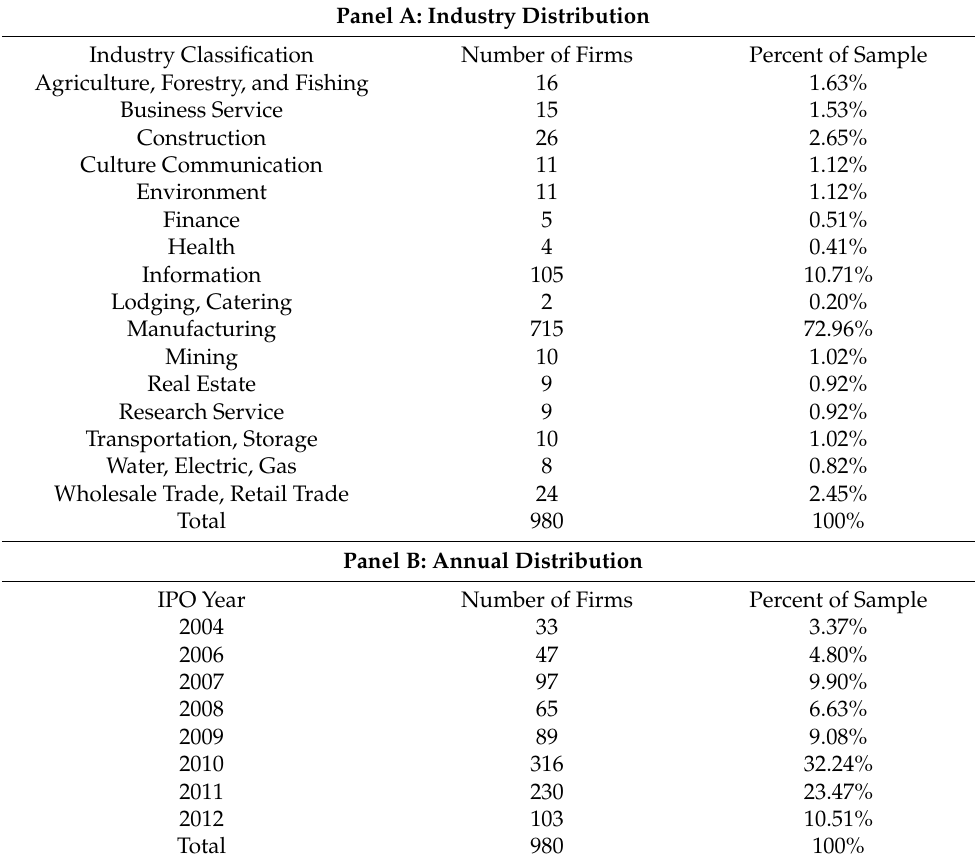
Table 1. Distribution of Sample by Industry and by Year. This Table reports the distribution of the sample by industry and by year. The full sample consists of 980 firm observations drawn from the SME and ChiNext on the ShenZhen Stock Exchange. The sample spans 2004 to 2012. The industry distributions are reported in Panel A and annual distributions are reported in Panel B. Panel A: Industry Distribution Industry Classification Number of Firms Percent of